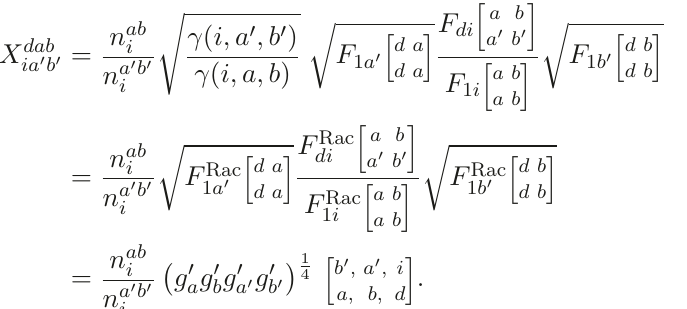
Figure 15 . Defect network manipulations determining the defect coefficients X dab the boundary insertion i is traded for a defect ending on the boundary. Along such a defect an ab -bubble is collapsed, after F -crossing on the original defect line d . The two junctions at which the defect d joins the boundary corresponds to square roots of F -matrix